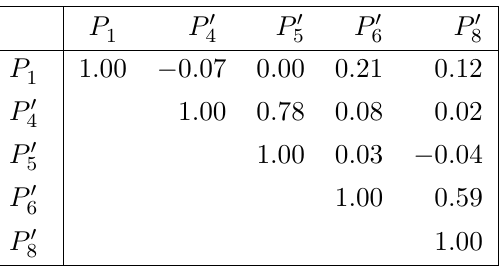
Table 11 . Statistical correlation matrix for the P (